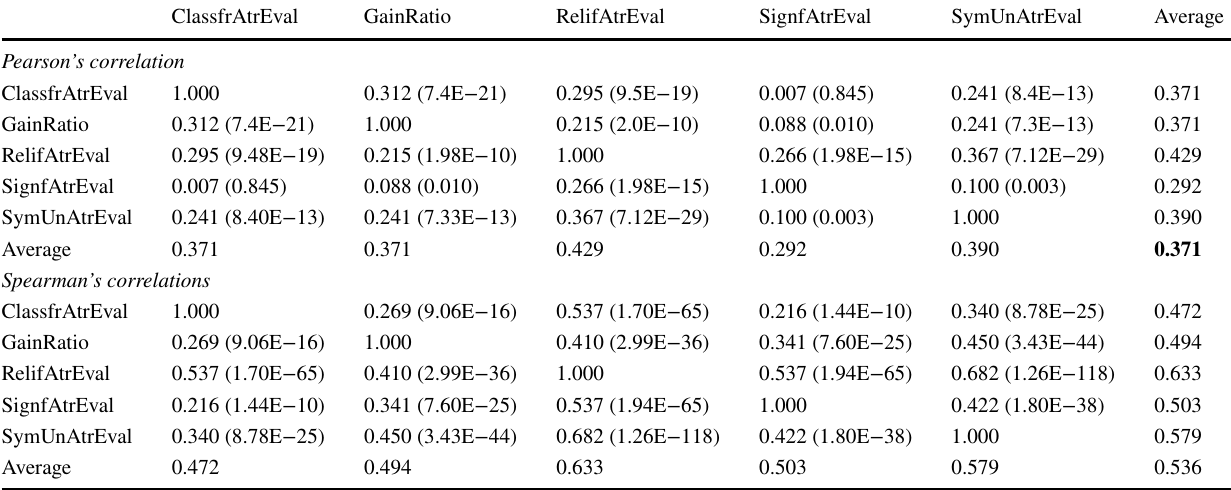
Table 7 The result of the diversity test using Pearson’s ( r ) and Spearman’s ( r s ) correlation coefficient with their corresponding P values